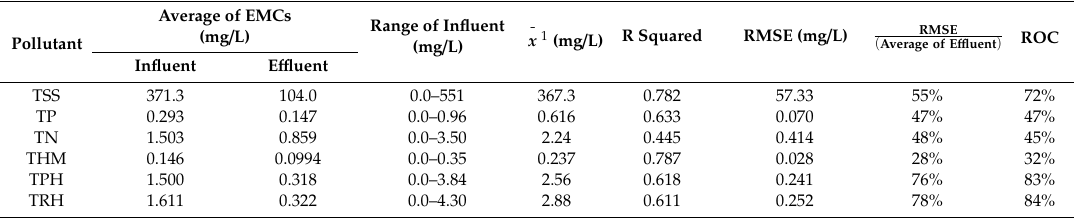
Table 8. Regression of concentration